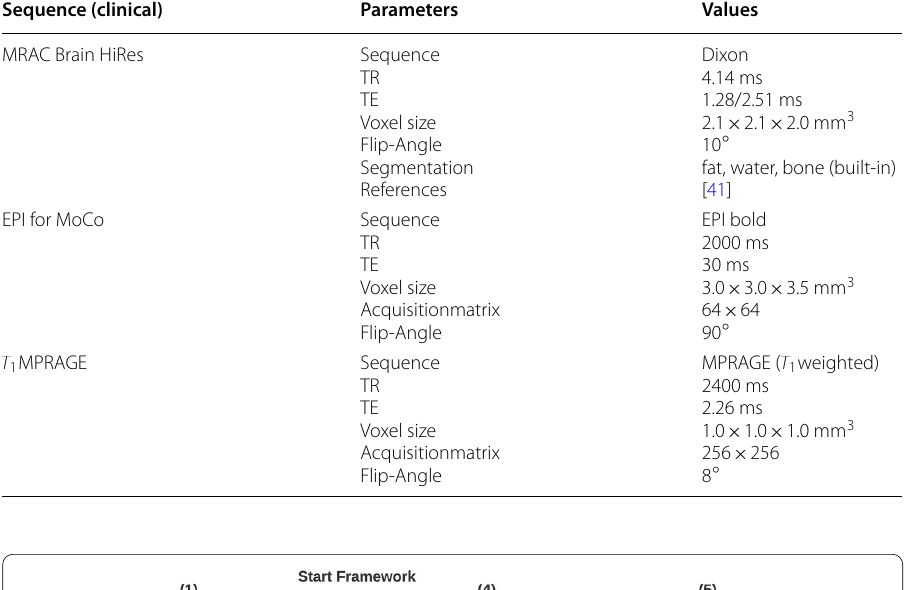
Table 1 Listing of the most important sequence parameters Sequence (clinical)